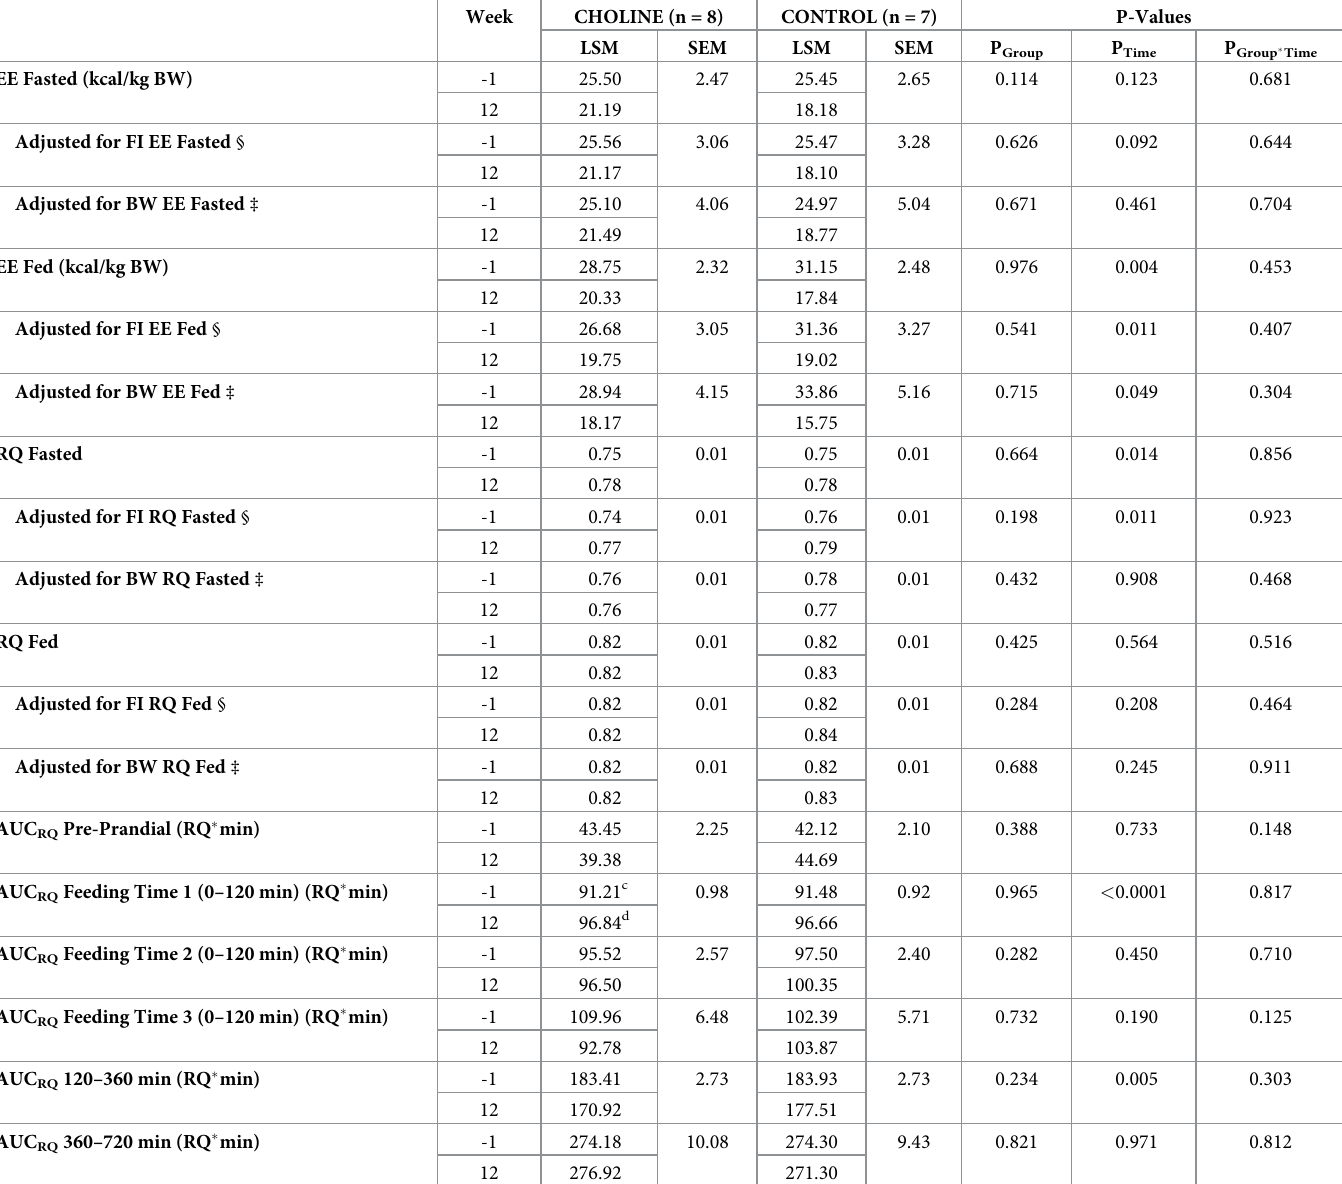
Table 6. Energy expenditure, respiratory quotient, and area under the curve for respiratory quotient of post-gonadectomy kittens supplemented with additional choline at 300 mg/kg BW 0.75 (CHOLINE, n = 8) for 12 weeks compared to a group fed only the base diet (CONTROL, n =